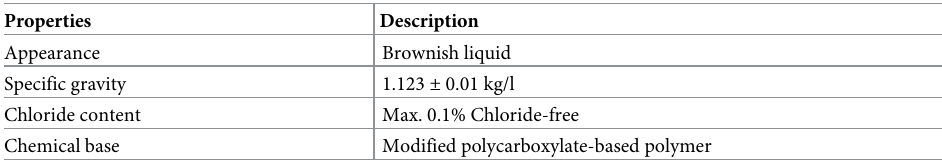
Table 4. Specifications of